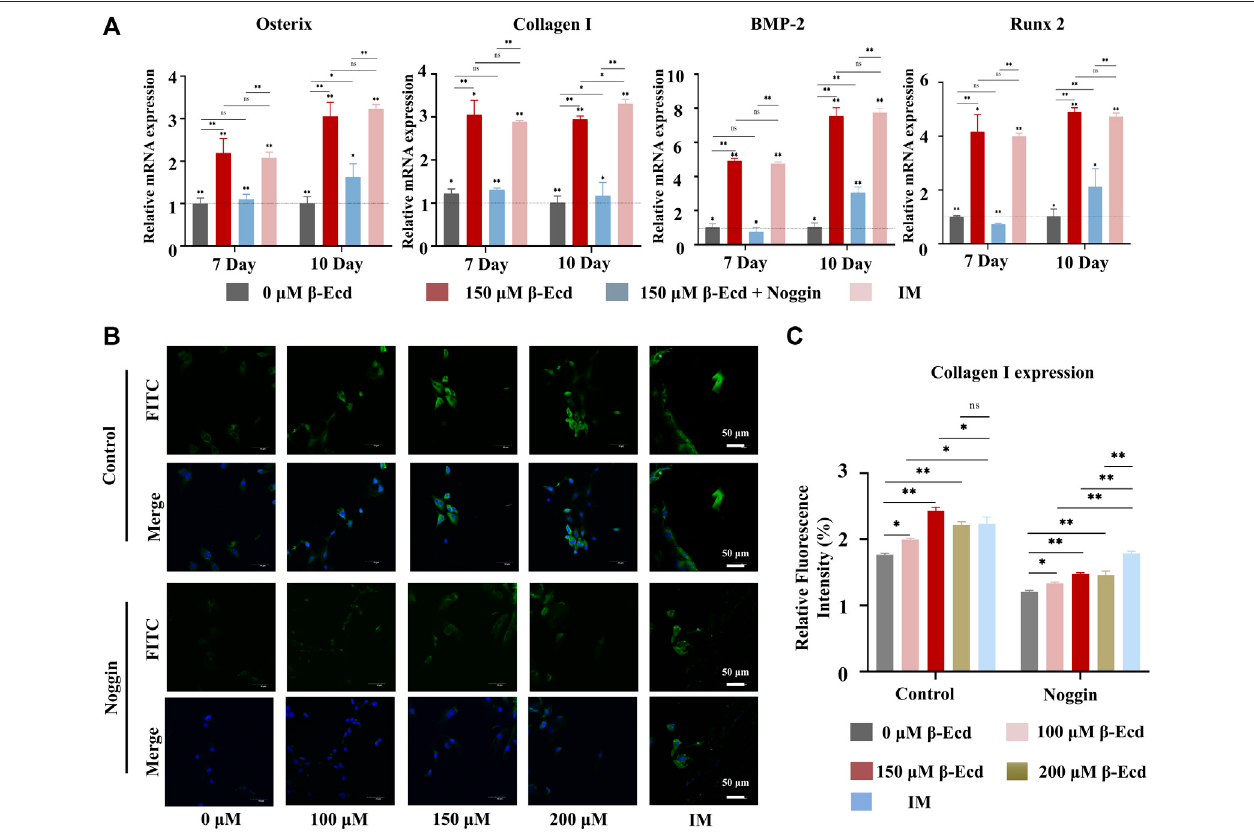
FIGURE 3 | β -Ecd promotes the expression of osteogenic proteins and genes. (A) The relative expression levels of osteogenic differentiation-related genes in MC3TE-E1 treated with induction medium, β -Ecd and noggin were determined by RT-qPCR. The results showed that β -Ecd could signi fi cantly increase the expression of osterix mRNA, Collagen I mRNA, BMP-2 mRNA, and Runx2 mRNA in cells; however, this effect could be inhibited by exposure to noggin. There was no signi fi cant difference compared with the IM group and 150 μ M β -Ecd group. The experiments were repeated three times and the results were normalized by the expression level of GAPDH. *p < 0.05, **p < 0.01. (B,C) Immuno fl uorescence (IF) staining to detect type I collagen expression in MC3T3-E1. After treating MC3TE-E1 with 0 μ M β - Ecd (control group) and 100 – 200 μ M β -Ecd (experimental group) or iduction medium for 10 days, the IF results showed that the expression of type I collagen in